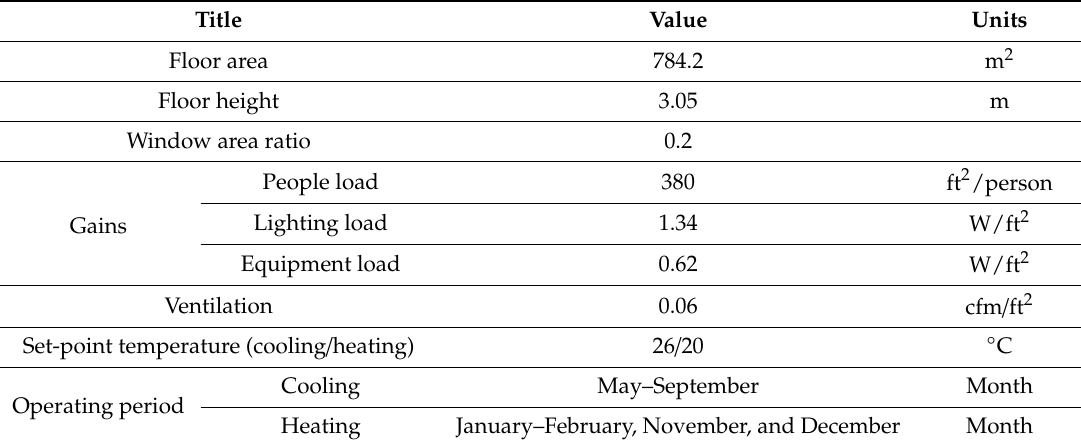
Figure 11. Occupancy, lighting, and equipment schedules of the apartment building. Table 4. Summary of the mid-rise apartment.